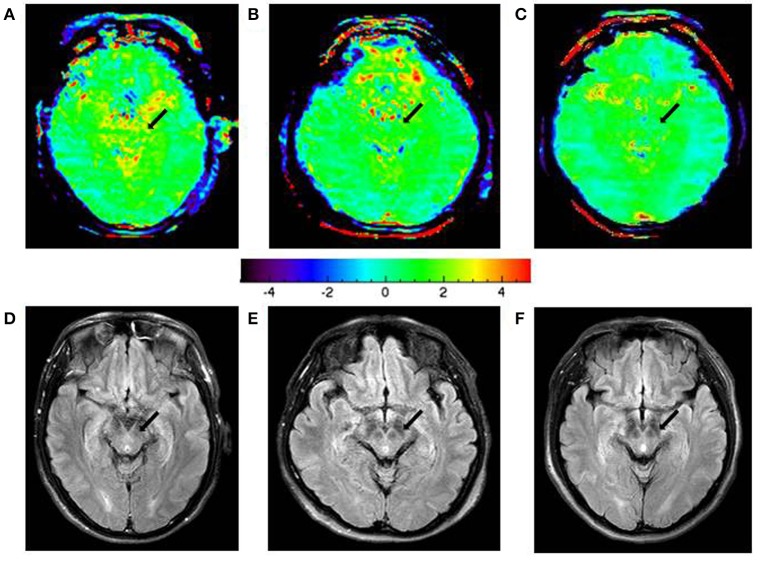
APTw images and FLAIR images of a typical normal control (A,D), an early-stage PD patient (B,E), and an advanced/late-stage PD patient (C,F). The APTw intensities in the substantia nigra (black arrows) were lower in PD patients (green color at the early stage, light blue color at the advanced/late stage) than in the normal controls (scattered yellow color).